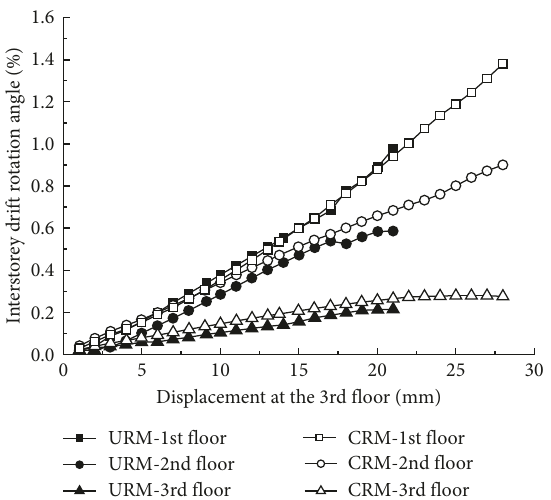
Figure 16: Interstorey drift rotation angle of URM and CRM